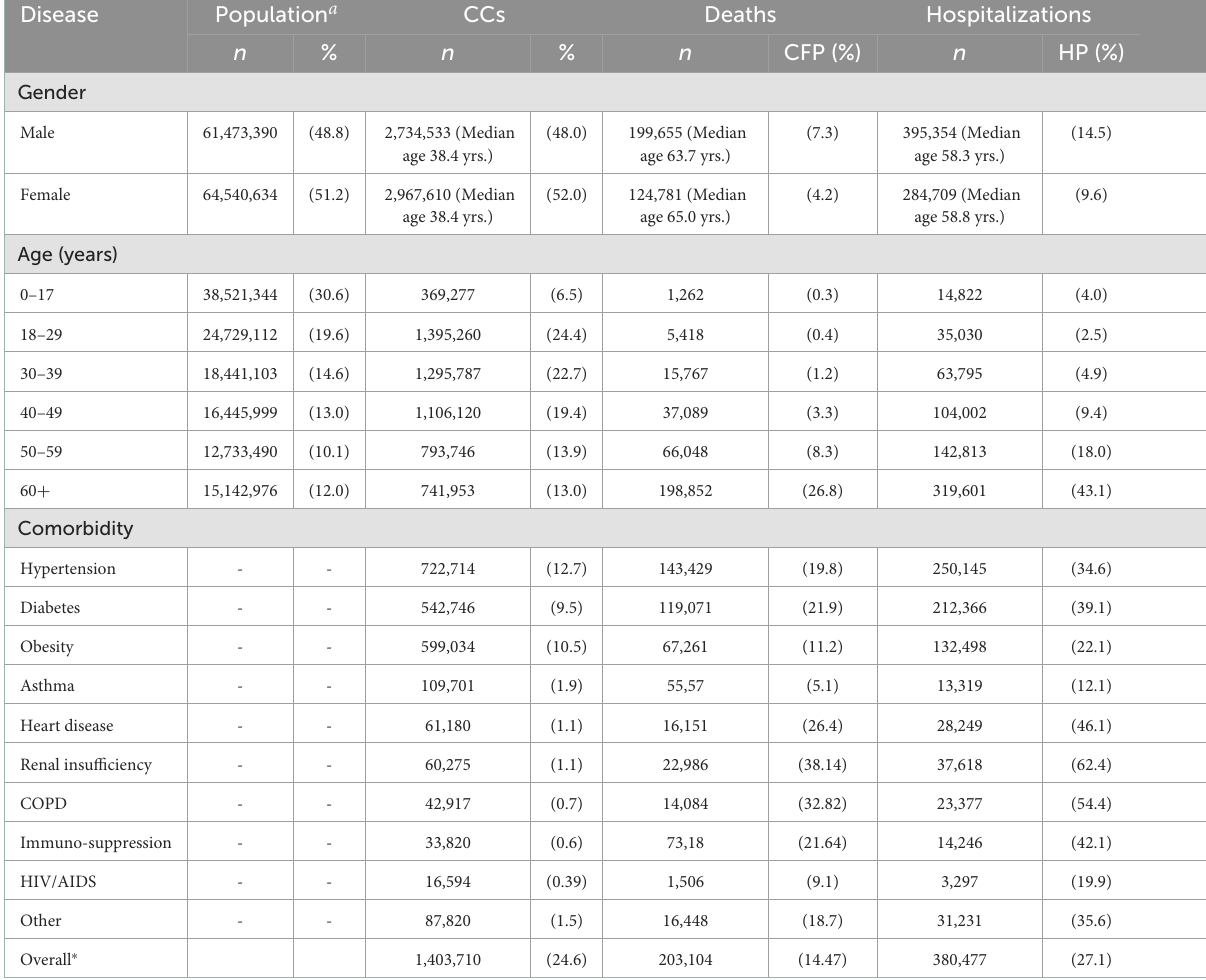
TABLE 1 Characteristics of COVID-19 infections, deaths, and hospitalization.